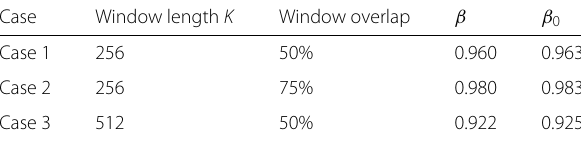
Table 2 Smoothing parameters of the a priori SNR estimation